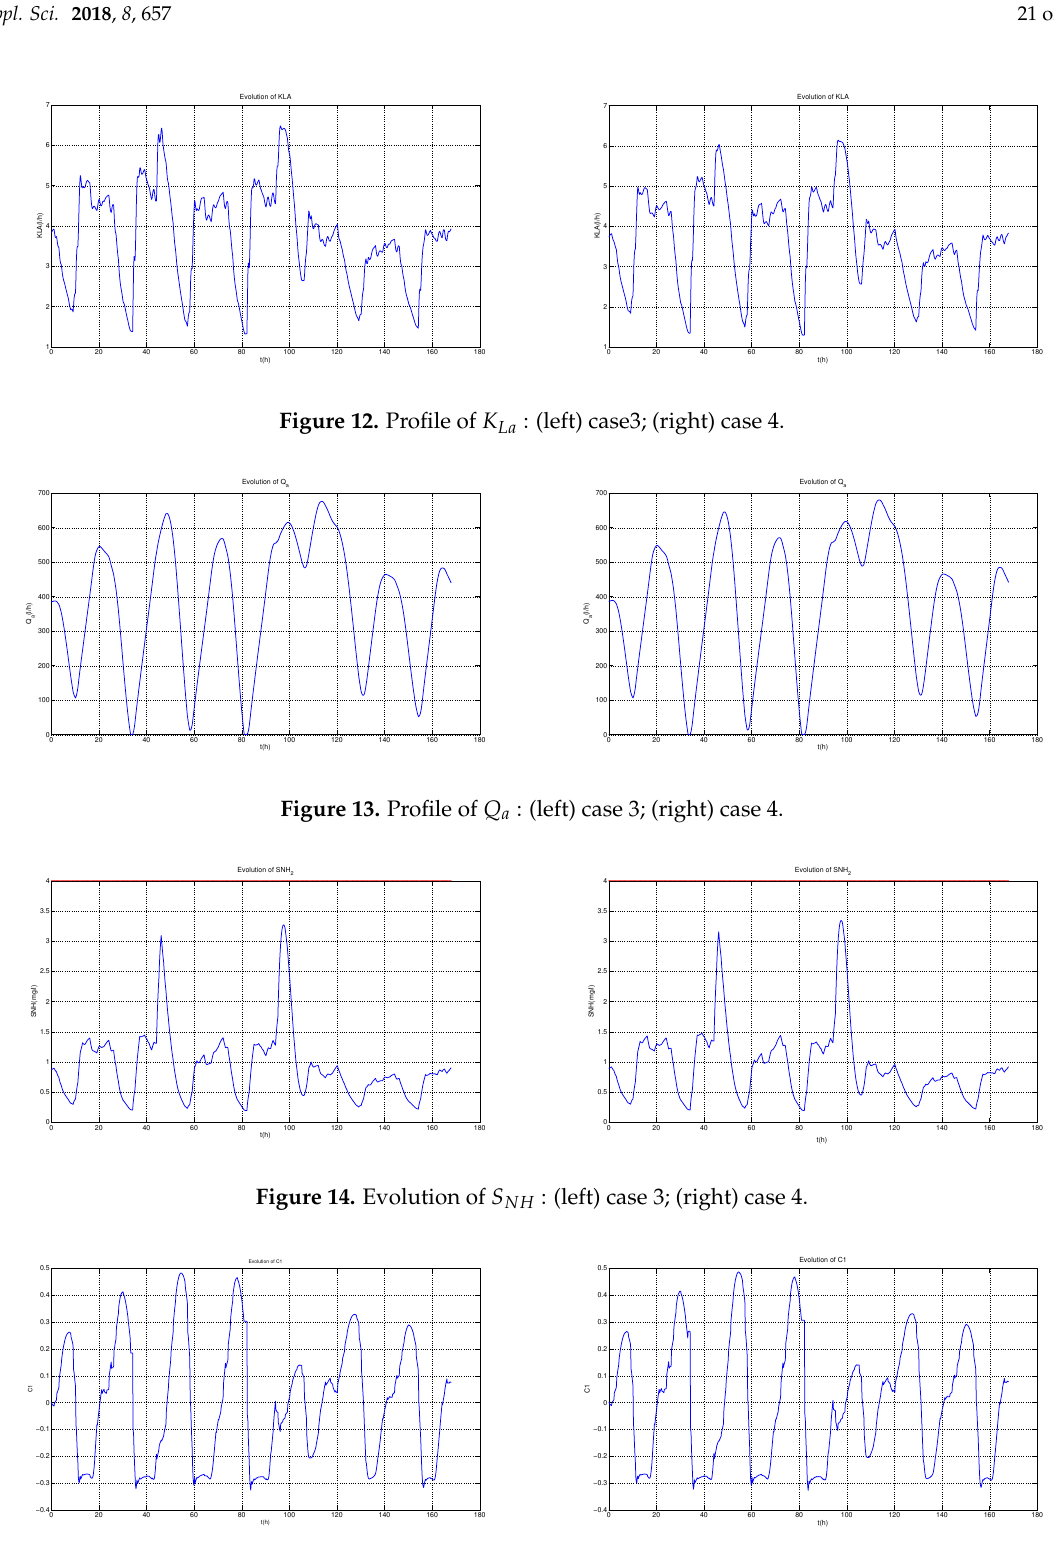
Figure 15. Evolution of the degree of freedom c 1 : (left) case3; (right) case